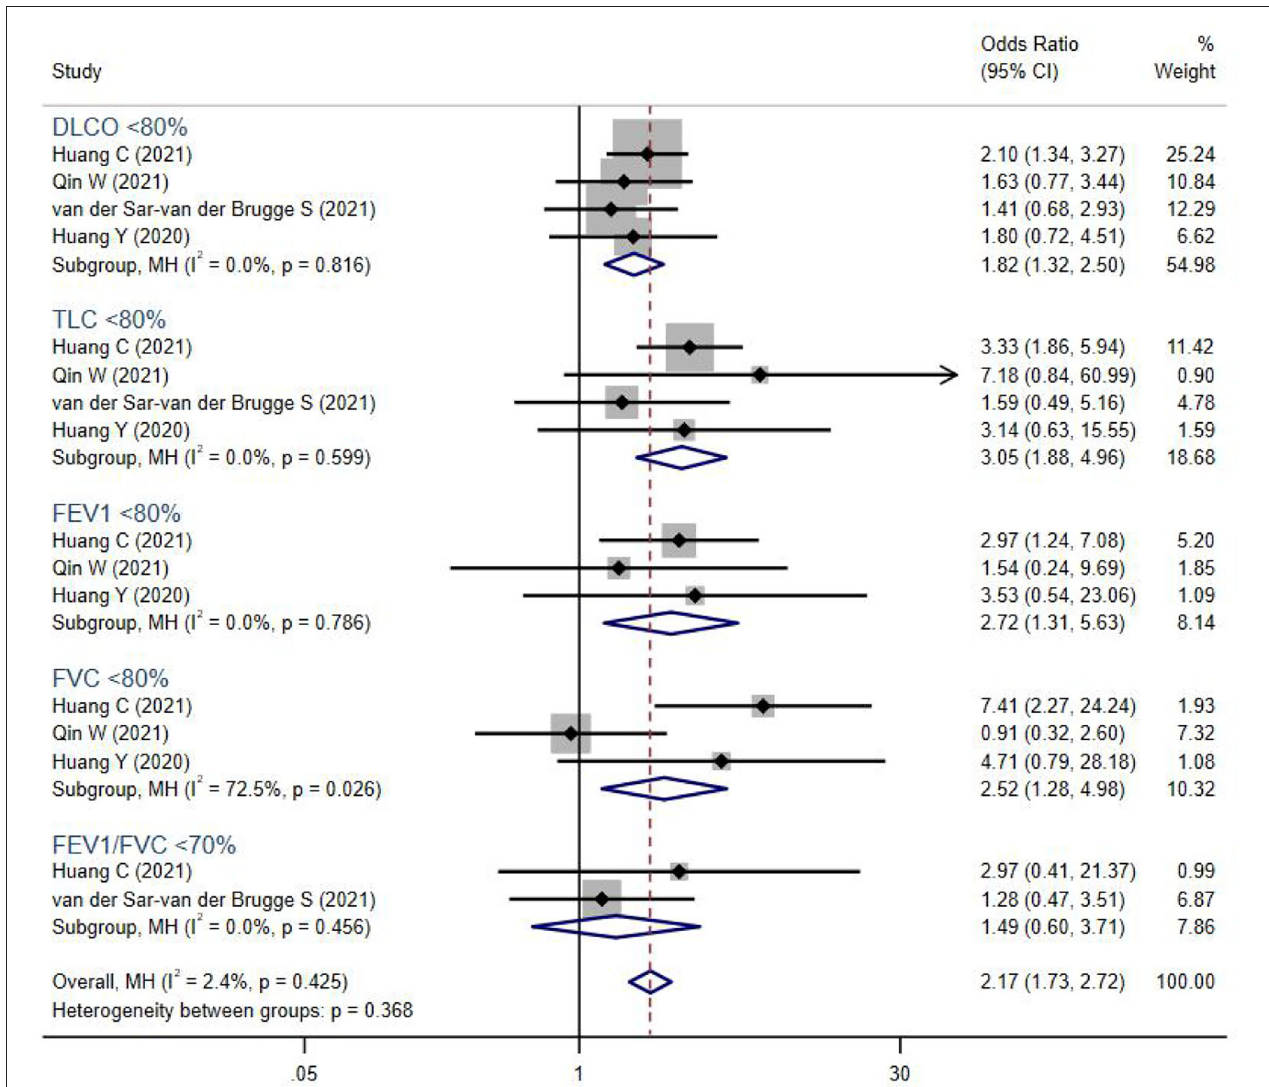
FIGURE 3 | The forest plot of the odds ratio (OR) for risk of abnormal lung function parameters in severe patients compared to non-severe patients, with a range from 0.91 to 7.41. The brown dashed line at 2.17 on the x-axis represents the overall odds ratio (OR 2.17, 95% CI 1.73–2.72) for these parameters. The blue rhombuses that are centered to the right of the vertical solid line indicate that severe patients are more likely to develop lung function abnormalities in the post-acute phase. DLCO, diffusion capacity for carbon monoxide; TLC, total lung capacity; FEV1, forced expiratory volume in the first second; FVC, forced vital